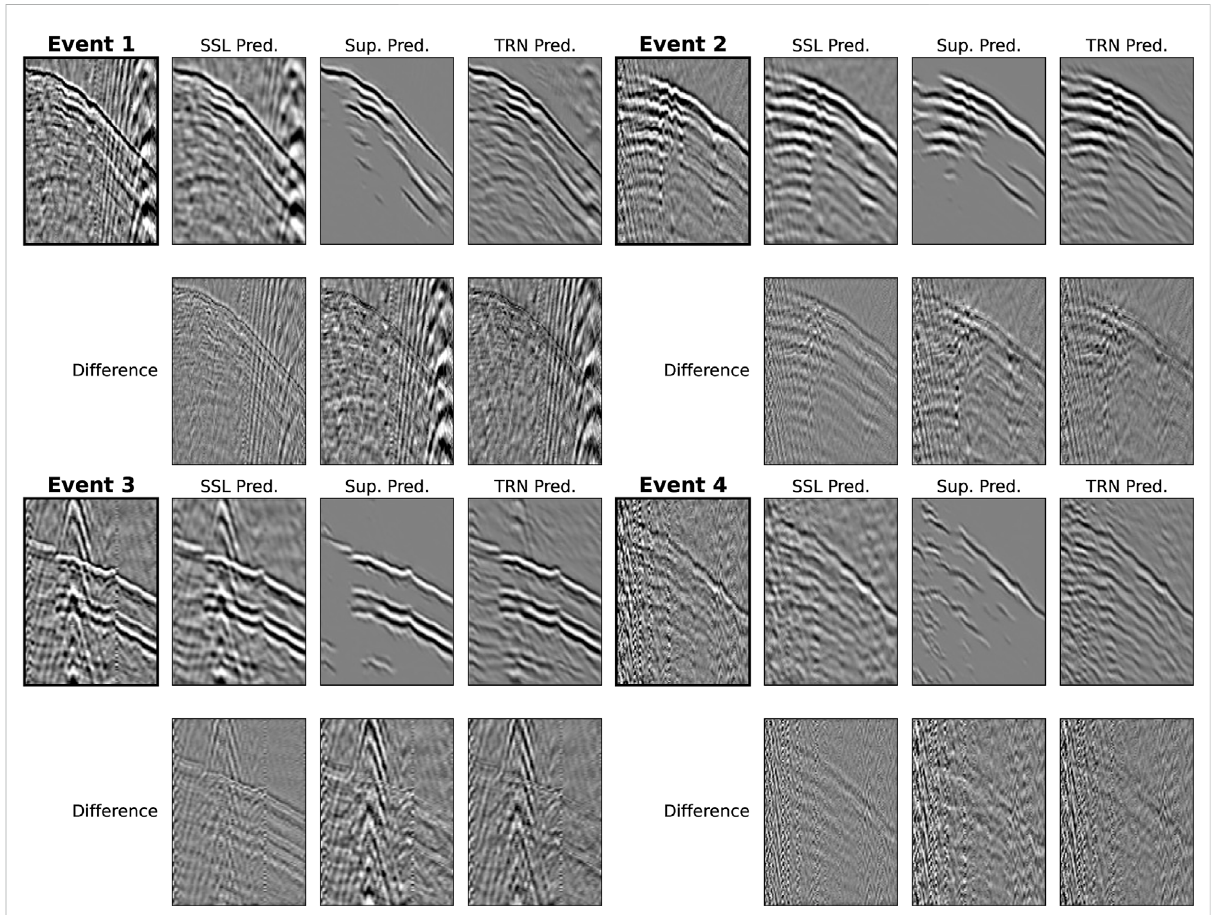
FIGURE 8 Comparison of the different denoising networks ’ performance on four different microseismic events observed within fi eld data. The top, left panelofeacheventshowstherawnoisydata,withtheremainingpanelsinthetoprowsshowingthedenoisingresultsforthedifferentnetworks.The bottom rows show the difference between the denoised products and the raw, noisy